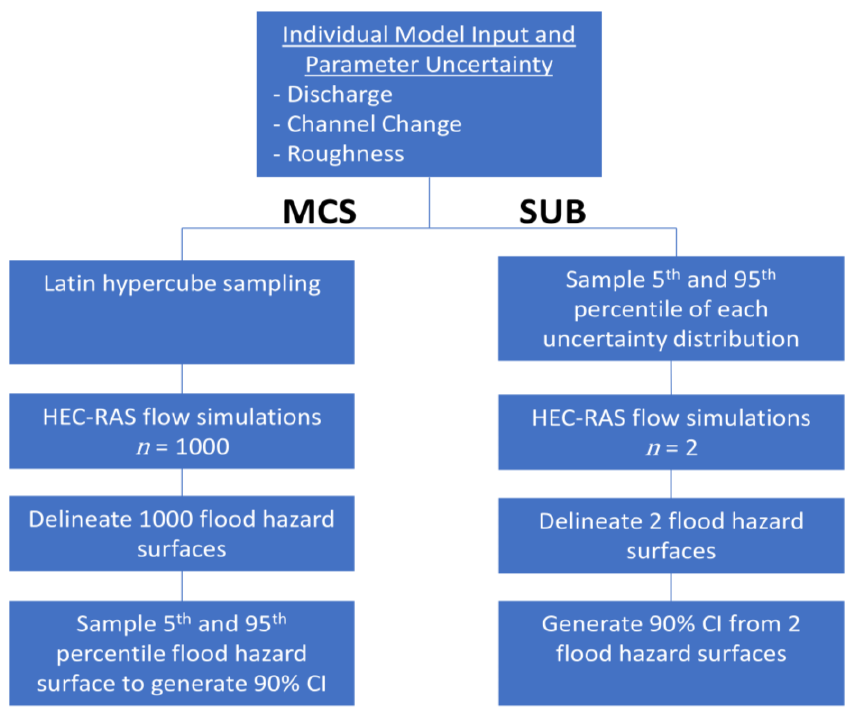
Figure 2. Flow chart describing the process to create a 90% confidence interval (CI) of flood hazard estimates using MCS and the SUB method.